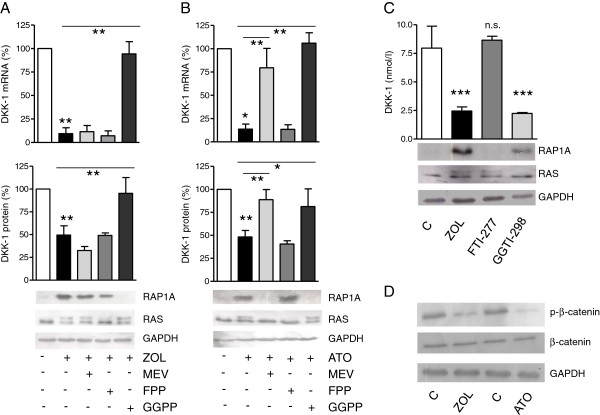
Dickkopf-1 is regulated via inhibited geranylgeranylation. (A), (B) MDA-231 cells were treated with either zoledronic acid (ZOL; 100 μM) or atorvastatin (ATO; 10 μM) for 24 hours alone or concurrently with mevalonate substrates (geranyl-geranyl-pyrophosphate (GGPP), farnesyl pyrophosphate (FPP) or mevalonate (MEV)). Dickkopf-1 (DKK-1) was analyzed by polymerase chain reaction (PCR) and enzyme-linked immunosorbent assay (ELISA). (C) Specific inhibitors of geranylgeranylation GGTI-298 (5 μM) and farnesylation FTI-277 (100 nM) were used for further pathway clarification, and treatment was for 24 hours. Results of ELISA and PCR data are presented as the mean ± standard deviation of three independent experiments. *P < 0.05; **P < 0.01; ***P < 0.001. Inhibition of geranylgeranylation by GGTI-298, atorvastatin and zoledronic acid, farnesylation by FTI-277, atorvastatin and zoledronic acid as well as their selective reversal by the substrates was confirmed by assessing unfarnesylated RAS and ungeranylated RAP1A in western blot. Glyceraldehyde 3-phosphate dehydrogenase (GAPDH) is used as loading control. Representative blots are shown. (D) Levels of phosphorylated β-catenin decrease following 24 hours of exposure to zoledronic acid and atorvastatin. Levels of total β-catenin remain unchanged. GAPDH is used as a loading control.